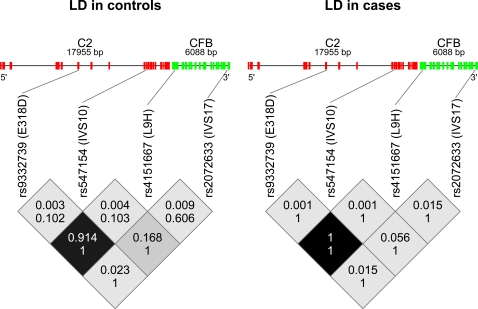
Linkage disequilibrium (LD) across the C2/CFB region in unrelated cases and controls.The darker the boxes the higher the r2. The top number in each box is r2 and the bottom number is D'. Locations of the SNPs within the genes are shown. Red lines/boxes show the locations of exons in C2 and green lines/boxes the locations of exons in CFB.